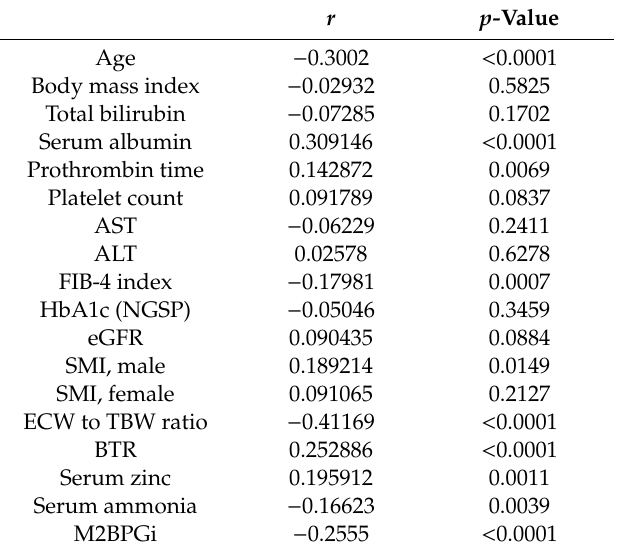
Table 2. Correlation between walking speed and baseline data other than handgrip strength.